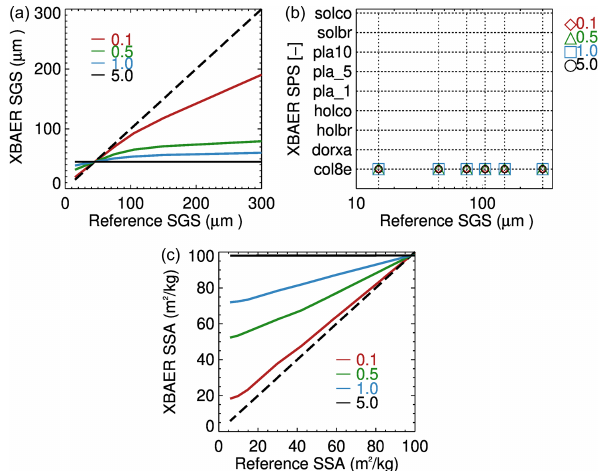
Figure 11. Impact of cloud contamination on the retrieval of SGS (a) , SPS (b) and SSA (c) . Different colors indicate different COTs in forward simulations; dashed black line is the 1 : 1